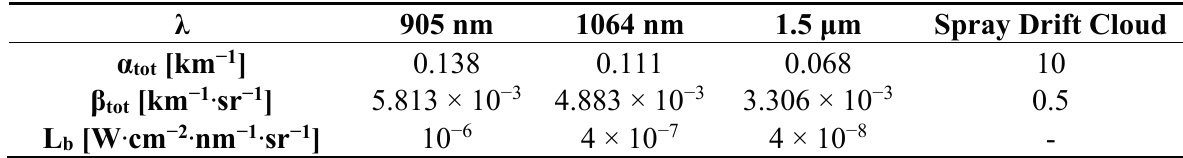
Table 1. Opto-atmospheric parameters and solar background radiance for the studied